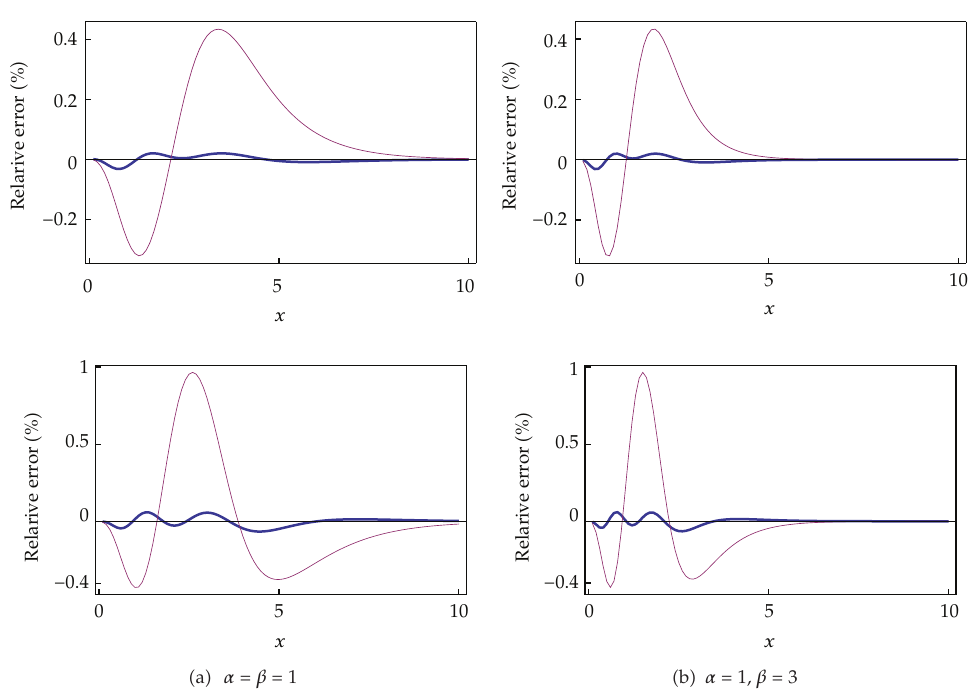
Figure 2: Relative % errors of the presented approximate solutions (cid:3) in upper row (cid:4) and those of their derivatives (cid:3) in lower row (cid:4) . Thin lines indicate the two term approximate solution g α,β (cid:3) x (cid:4) , and thick lines indicate the three-term approximate solution k α,β (cid:3) x (cid:4)